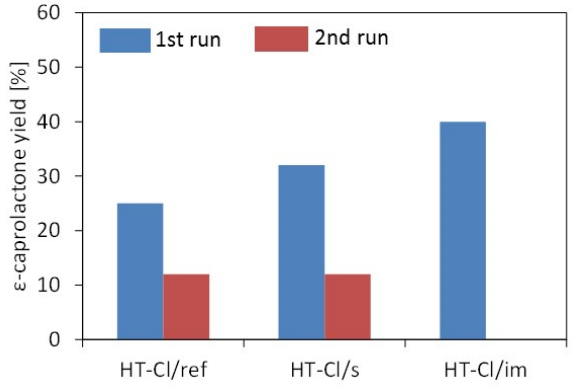
Figure 7. Recycling experiments using the chloride forms of the HT catalysts.